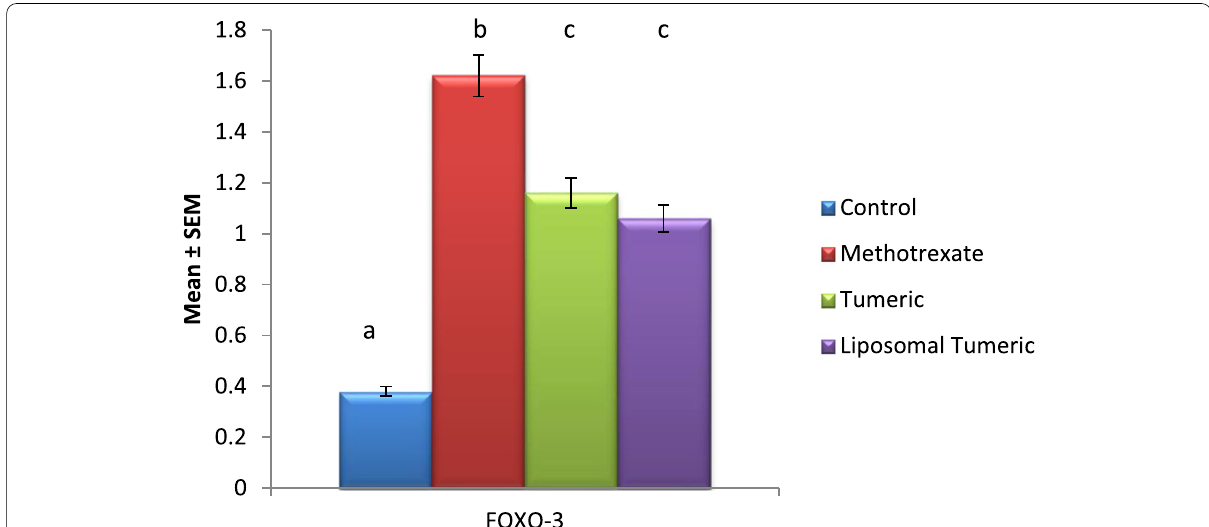
Fig. 5 Impact of turmeric and liposomal turmeric on serum inflammatory marker FOXO-3 protein expression post methotrexate intoxication. Data are expressed as mean SEM ( n 10). p value is considered significant. Groups having the same letter are not significantly different from each ± = other, while those having different letters are significantly different from each